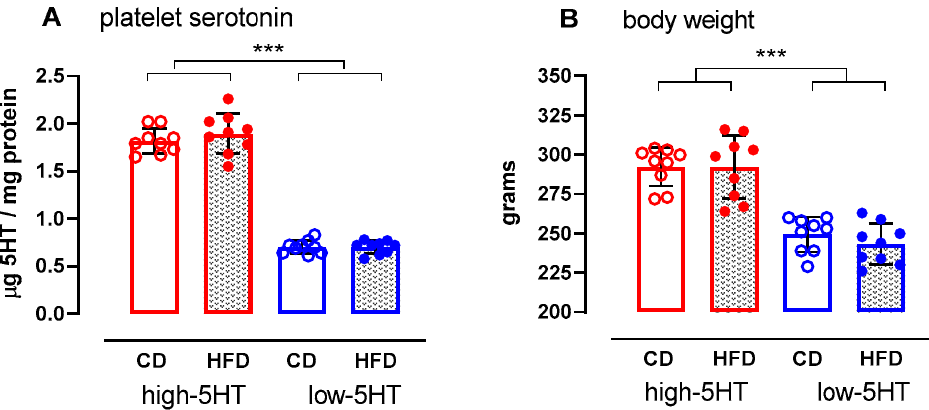
Figure 1. Platelet serotonin (5HT) levels ( A ) and body weight ( B ) in high-5HT and low-5HT animals used in the study. Platelet serotonin level was determined two weeks before initiation of the controlled feeding while body weight was monitored for one week before initiation of the controlled feeding. Data are presented as individual values and means ± SD, N = 9 per group; *** p < 0.0001 (LSD post-hoc test after one-way ANOVA), CD = control diet; HFD = high-fat diet.